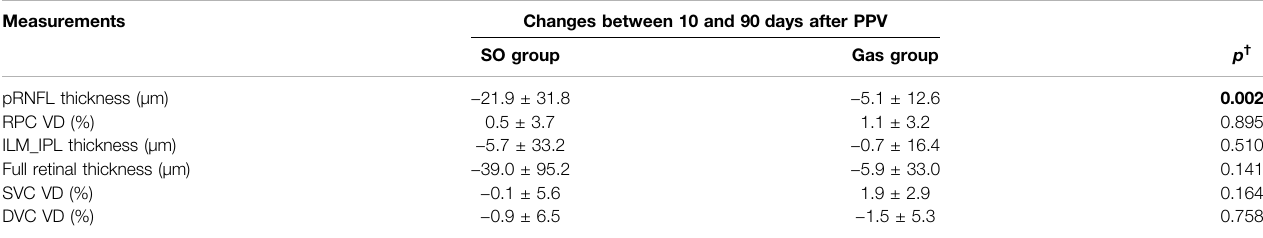
TABLE 3 | Intergroup differences in longitudinal changes in evaluation indicators a .